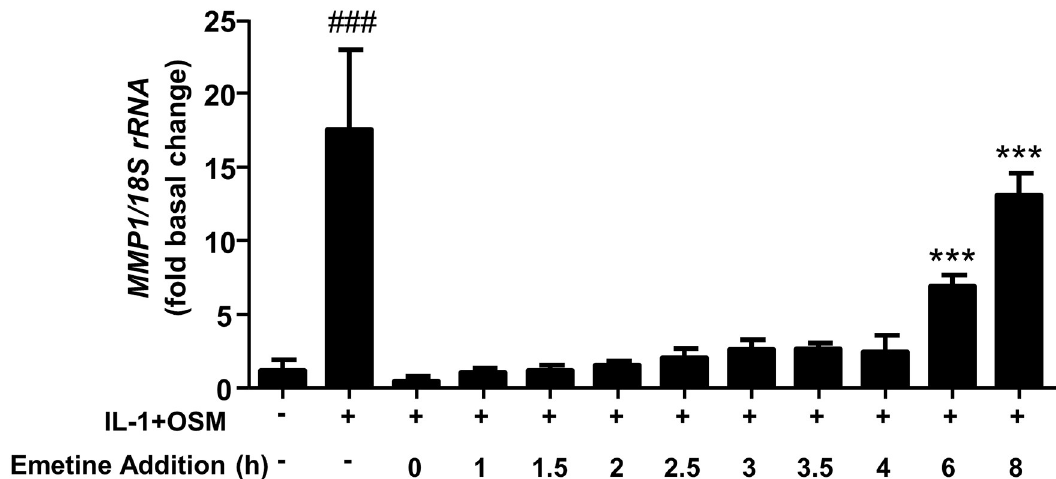
Fig 3. IL-1+OSM-induced MMP1 expression is dependent on new protein synthesis. Chondrocytes were treated with IL-1 (0.05 ng/mL) and OSM (10 ng/mL) for 24 h. Emetine (10 μ M final concentration) was added at the indicated times after initiation of IL-1 +OSM stimulation and qPCR performed on extracted RNA. Relative expression levels of MMP1 mRNA were normalized to 18S rRNA, where ### , p < 0.001 (IL-1+OSM vs basal); ��� , p < 0.001 (IL-1+OSM+emetine vs basal). Data (mean ± SD, n = 6) are representative of three separate experiments each using chondrocyte cultures from different